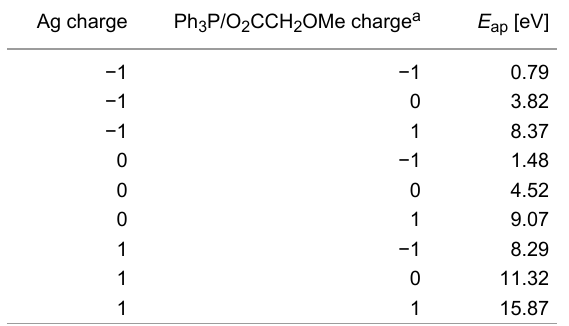
Table 1: Appearance energy (Equation 2) of differently charged Ag and Ph 3 P/O 2 CCH 2 OMe fragments from dissociation of mononuclear 2 .